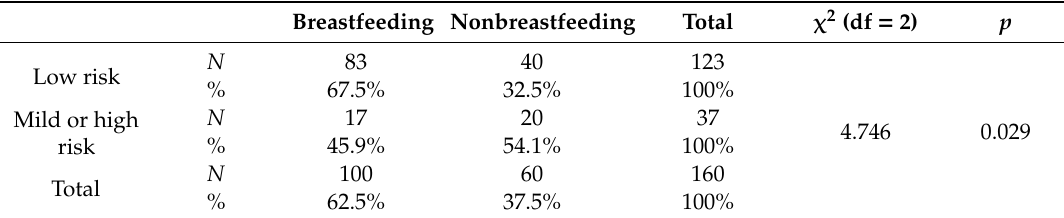
Table 3. Breastfeeding three months after birth in mothers with low, mild, or high risk for perinatal depression.